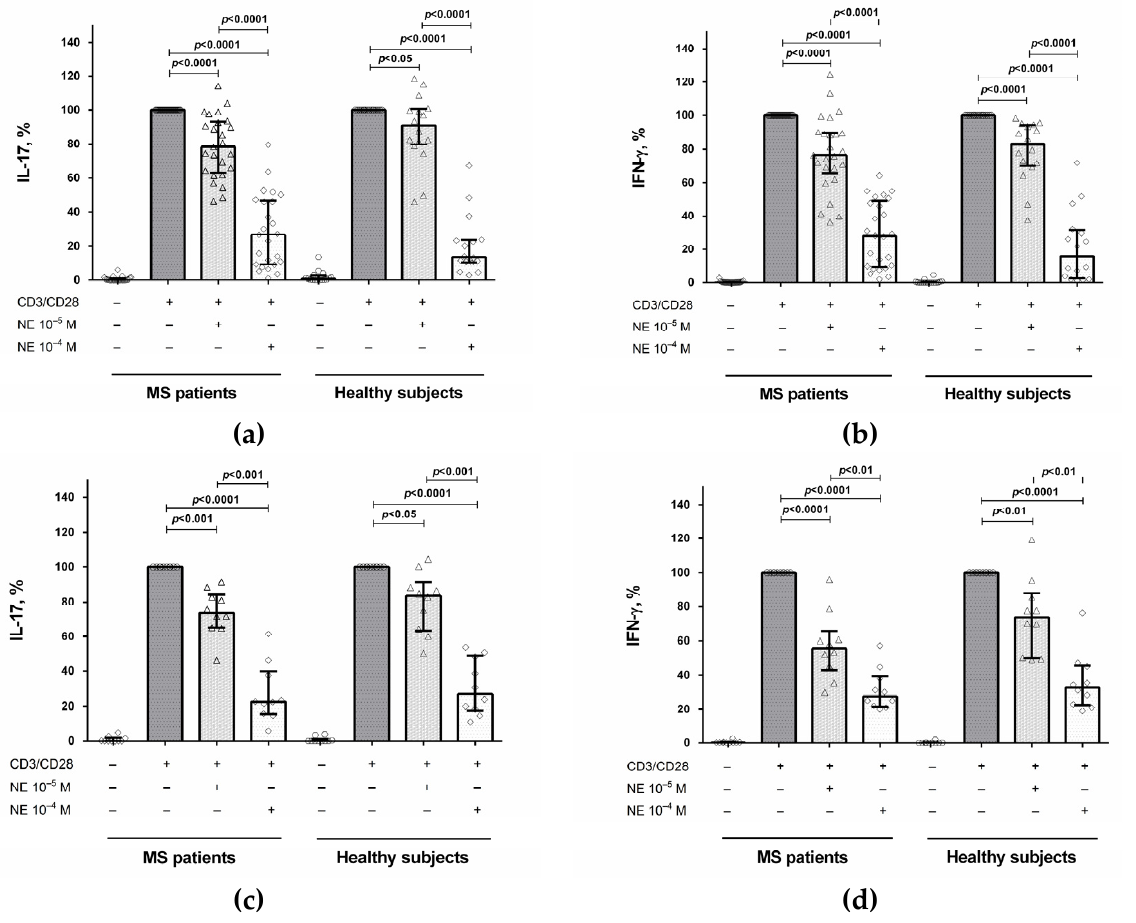
Figure 1. The influence of norepinephrine on IL-17 and IFN- γ production by stimulated CD4 + T cells ( a , b ) and PBMCs ( c , d ) in MS patients and healthy subjects. CD4 + T cells or PBMCs (8 × 10 4 per 200 µ L per well), obtained from MS patients or from healthy subjects, were activated with microbeads coated with anti-CD3 and anti-CD28 antibodies with or without norepinephrine at concentrations of 10 − 5 M and 10 − 4 M. After 72 h, the supernatants were collected and submitted to cytokine quantification by ELISA. Data are expressed as the percentage of cytokine production by stimulated cells in the absence of norepinephrine. The boxes in the graphs correspond to the medians and whiskers indicate the 25th and 75th percentiles. The symbols in the graphs correspond to the data from each separately MS patient or healthy subject. The median values of the MS and control groups were compared, and the p values are indicated in the